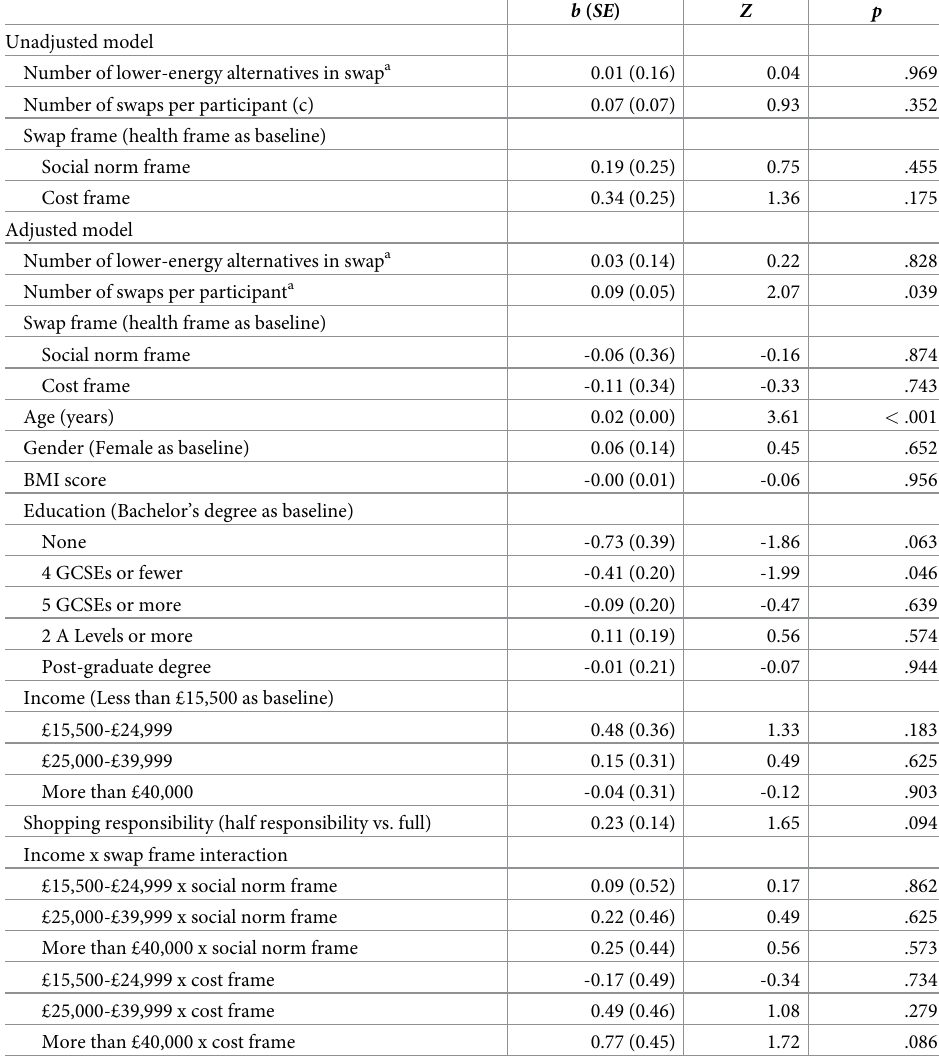
Table 2. Model summaries for the main analyses on the outcome of swap